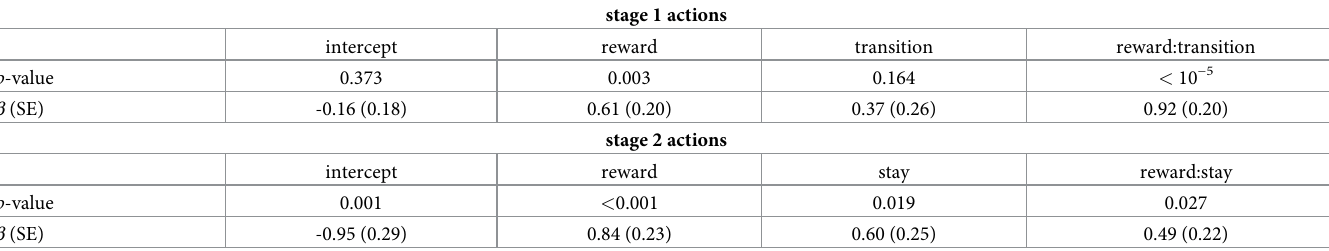
Table 2. Results of the logistic regression analysis of stage 1 and stage 2 choices in the probe session. For the stage 1 choices, the analysis focused on staying on the same stage 1 action on the next trial, based on whether the previous trial was rewarded and whether it was common or rare (trans). ‘reward:transition’ is the interaction between reward, and transition type. For stage 2 choices, the analysis focused on staying on the same stage 2 action, based on staying on the same stage 1 action (stay) and earning a reward on the previous trial. ‘reward:stay’ is the interaction between ‘reward’, and